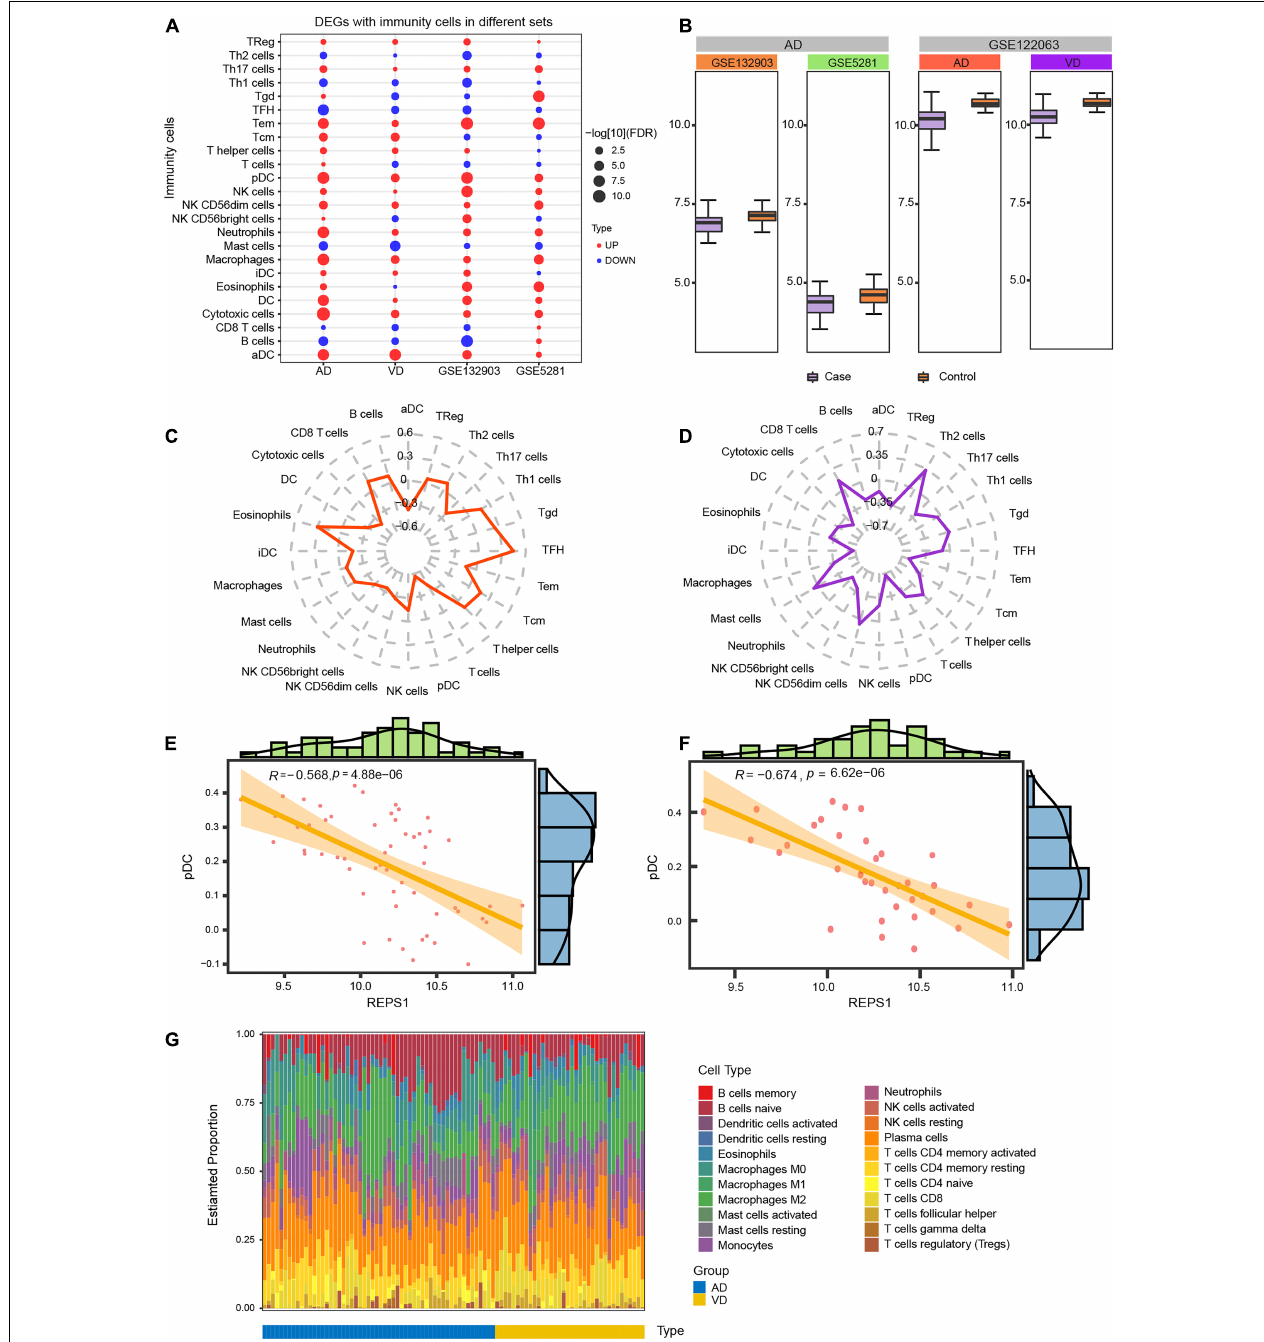
FIGURE 6 | Degree of infiltration by immune cells in Alzheimer’s disease (AD) and vascular dementia (VD). (A) Differential infiltration by immune cells in the datasets GSE122063 (AD and VD), GSE132903, and GSE5281. (B) Expression of REPS1 in the datasets GSE122063 (AD and VD), GSE132903, and GSE5281. (C, D) Correlation of REPS1 expression with infiltration by 24 types of immune cells in AD and VD. (E, F) REPS1 negatively correlated with plasmacytoid dendritic cells (pDCs) in AD and VD. (G) Estimated proportions of 22 immune cell types in AD (blue) or VD